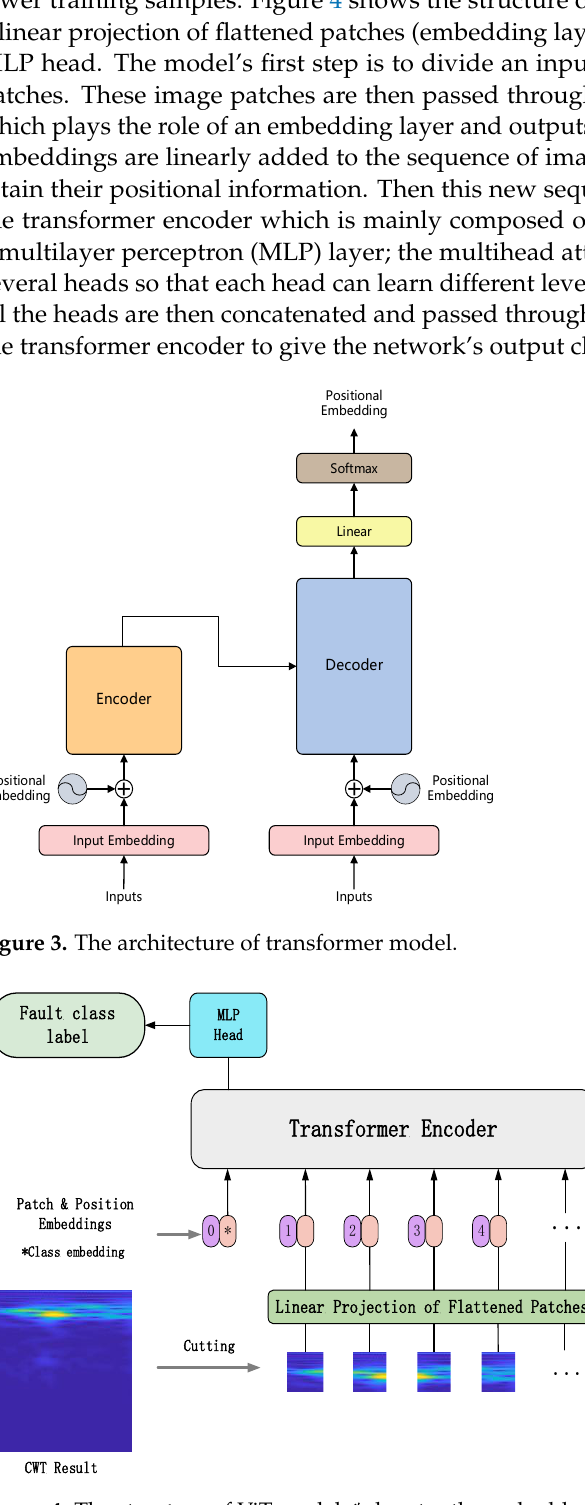
Figure 4. The structure of ViT model. * denotes the embedded class label vector.